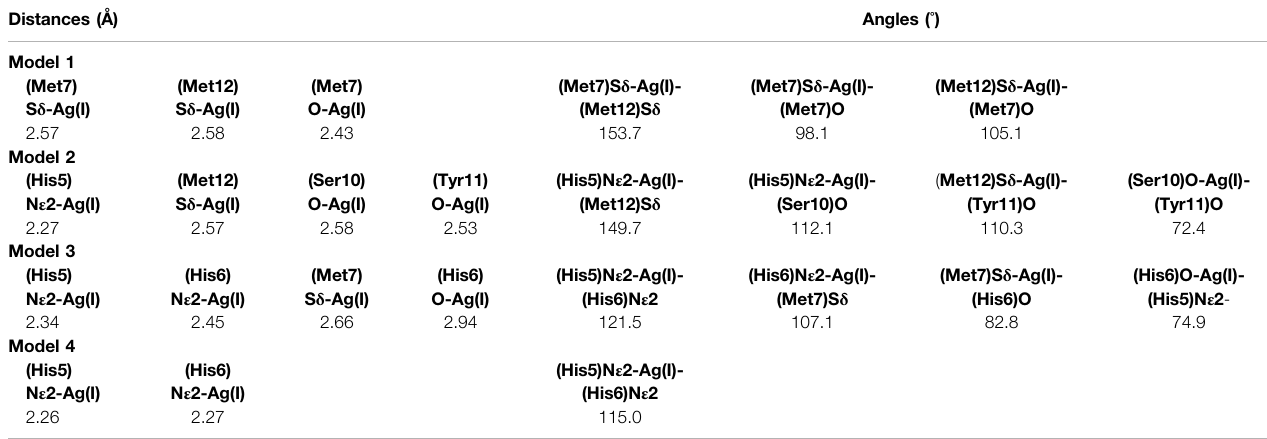
TABLE 2 | Coordination parameters derived from the optimized coordinates in gas phase. Distances are reported interatomic distances (in Angstroms) and angles (in degrees) are de fi ned by the atom names (peptide residues are indicated in brackets). Distances (Å) Angles ( ° ) Model 1 (Met7)